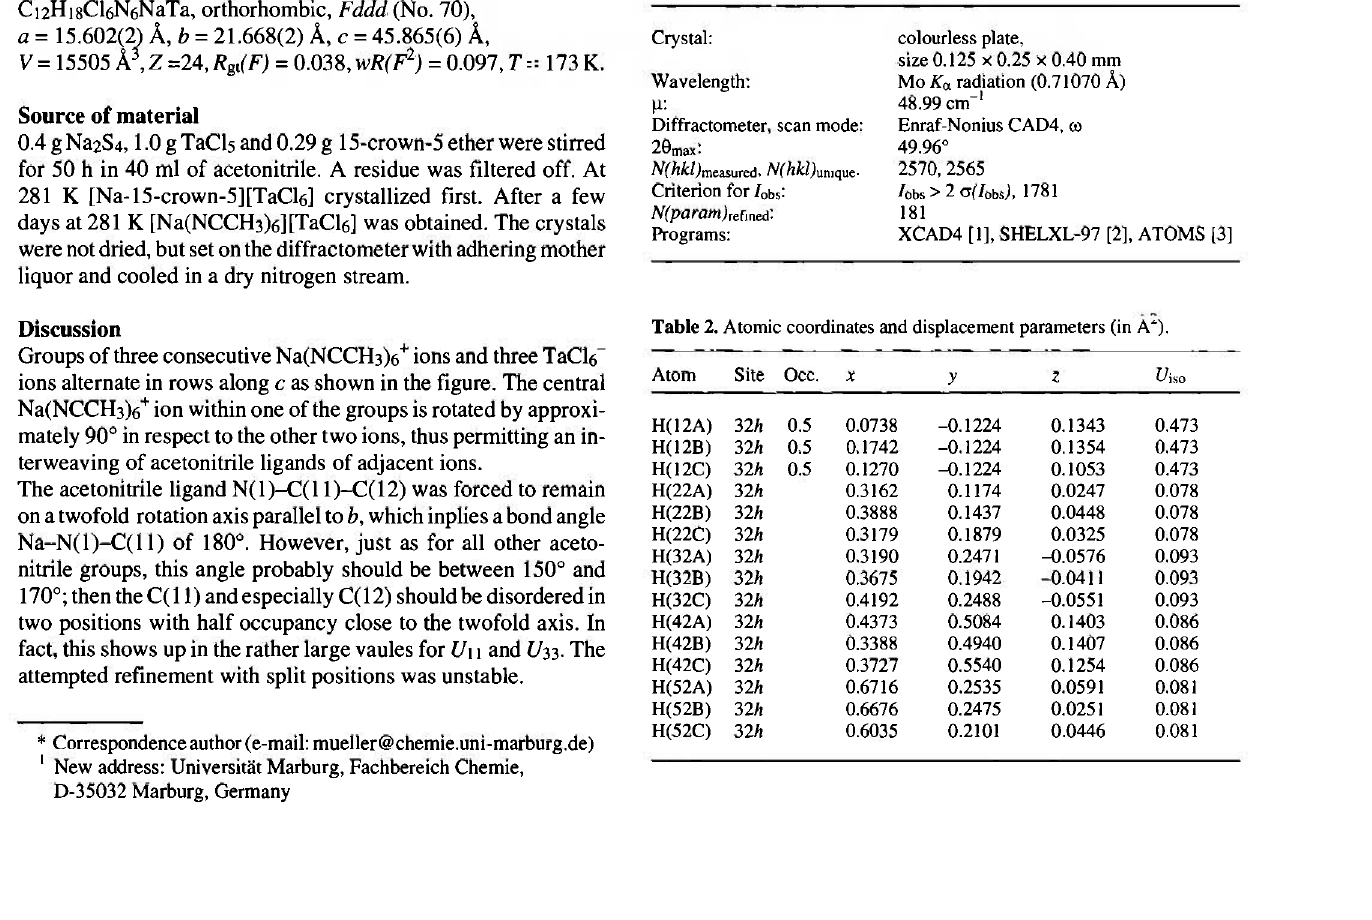
Table 1. Data collection and handling.